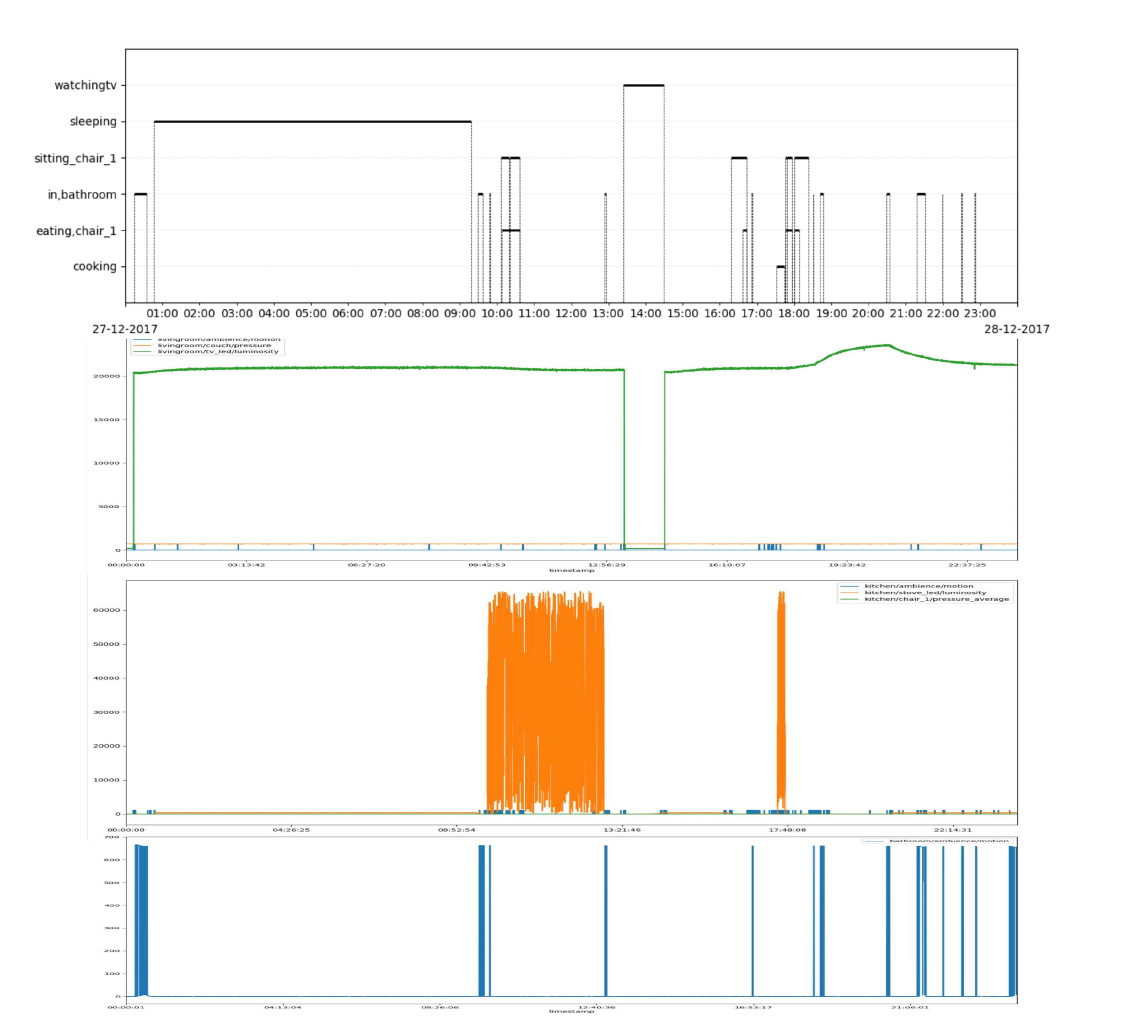
Figure 7. An example of the data gathered from the campaign: The top row shows the activities as labelled by the user, the second rows shows activation from the sensors in the living room, the third row shows activation from the kitchen, and the last row shows activation from the bathroom. Please note that the TV LED is lit when the TV is off while the oven LED is lit when the over is on. We can see from row 3 that the oven LED is on between 09:00 and 13:00, while the cooking activity has not been labelled, which might indicate that the user turned the oven on by mistake and forgot about